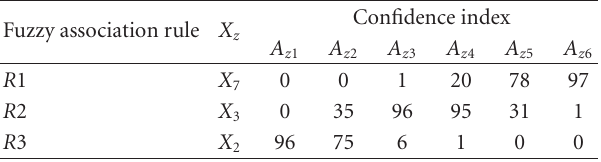
Table 8: Percentages of the confidence index for the fuzzy association rules.